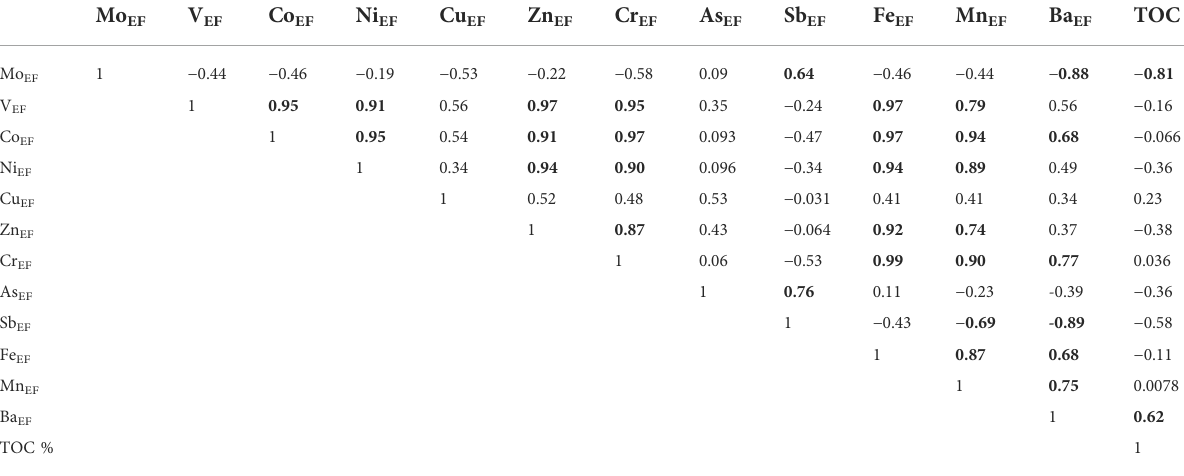
TABLE 4 Results of Pearson correlation analysis of site